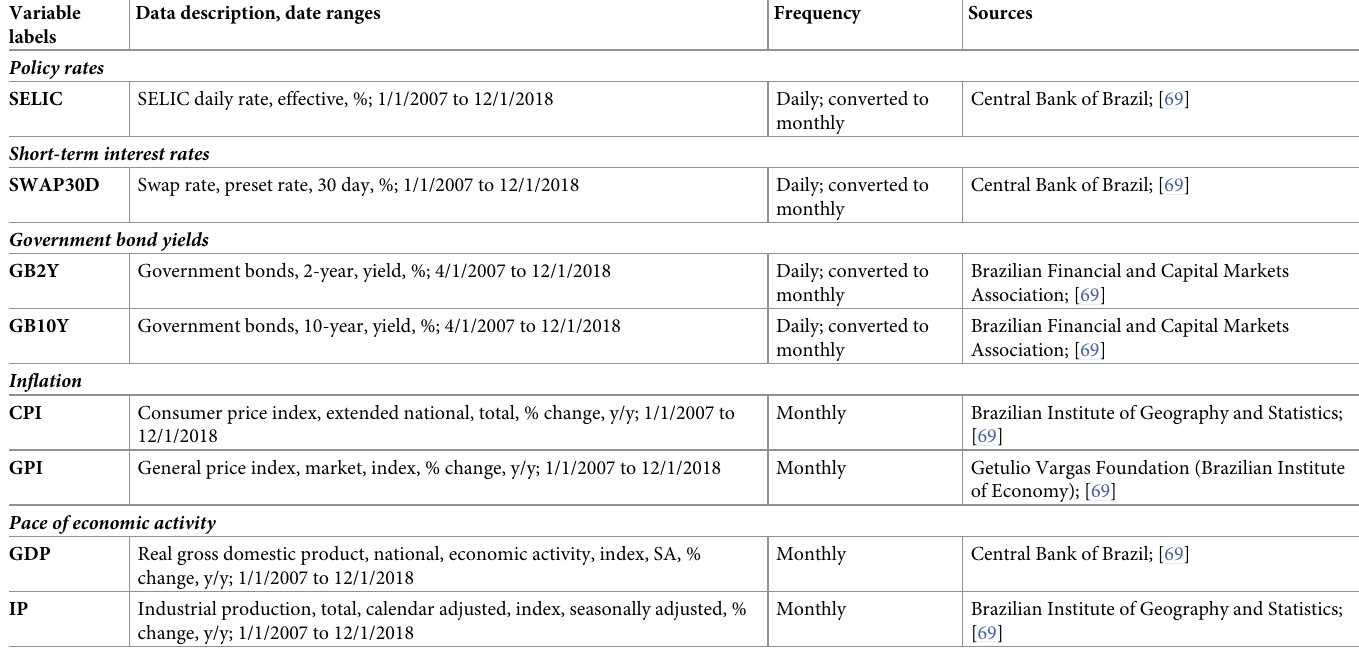
Table 1. Summary of the data and the